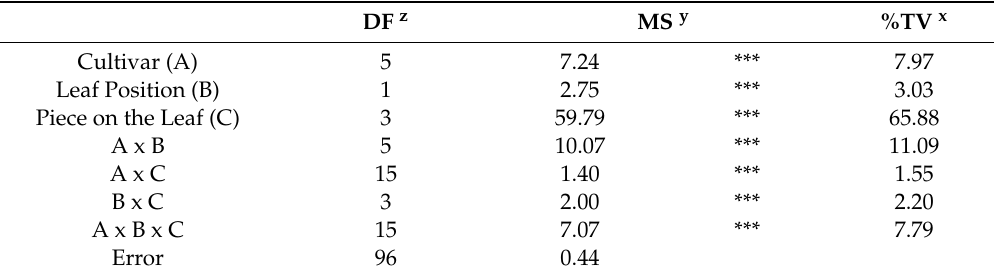
Table 2. Analysis of variance for shelf life of fresh-cut butterhead lettuce, during storage at 10 ◦ C for 7 days.